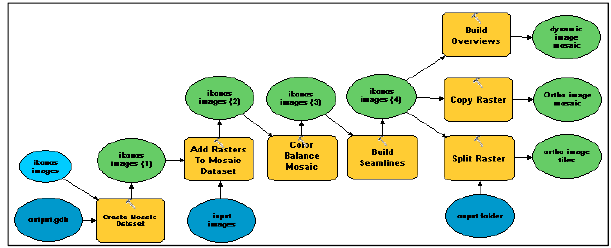
Figure 8. Geoprocessing model creating a virtual mosaic, a mosaicked TIFF, and image tiles